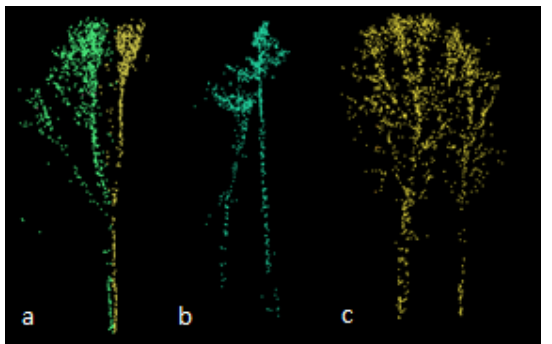
Figure 8. Examples of common segmentation errors: a – oversegmentation due to diverging branches (plot B), b – undersegmentation due to leaning tree (plot A), c – undersegmentation due to crown overlap (plot C).